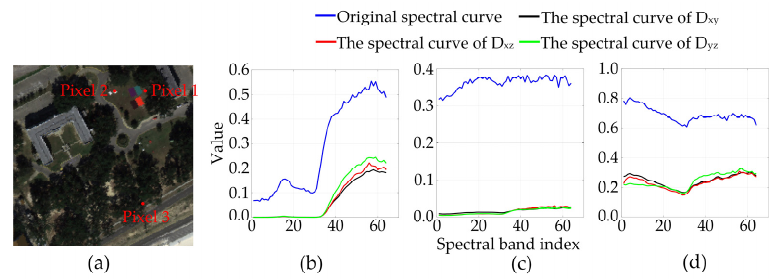
Figure 2. The spectral curves before and after the transformation of the three–dimensional Hessian matrix of three random pixels in the MUUFL Gulfport HSI: ( a ) three pixels selected in the MUUFL Gulfport HSI; ( b ) the spectral curve of pixel 1 before and after the transformation of the three– dimensional Hessian matrix; ( c ) the spectral curve of pixel 2 before and after the transformation of the three–dimensional Hessian matrix; ( d ) the spectral curve of pixel 3 before and after the transformation of the three–dimensional Hessian